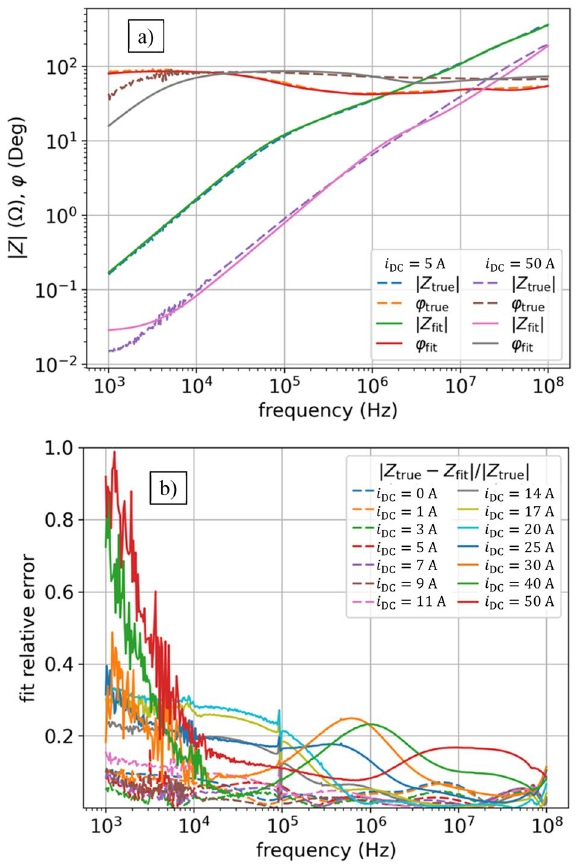
Figure 11. DA results of impedance Z ( f , i DC ) fitting for model (6): ( a ) fit vs true values of | Z | (cid:31) f , i DC (cid:30) and ϕ( f , i DC ) for two currents: i DC = 5 A, i DC = 50 A; ( b ) relative error as per (4) for all currents. DA gives a bit worse results on model (6) than DE (compare with Fig. 8).